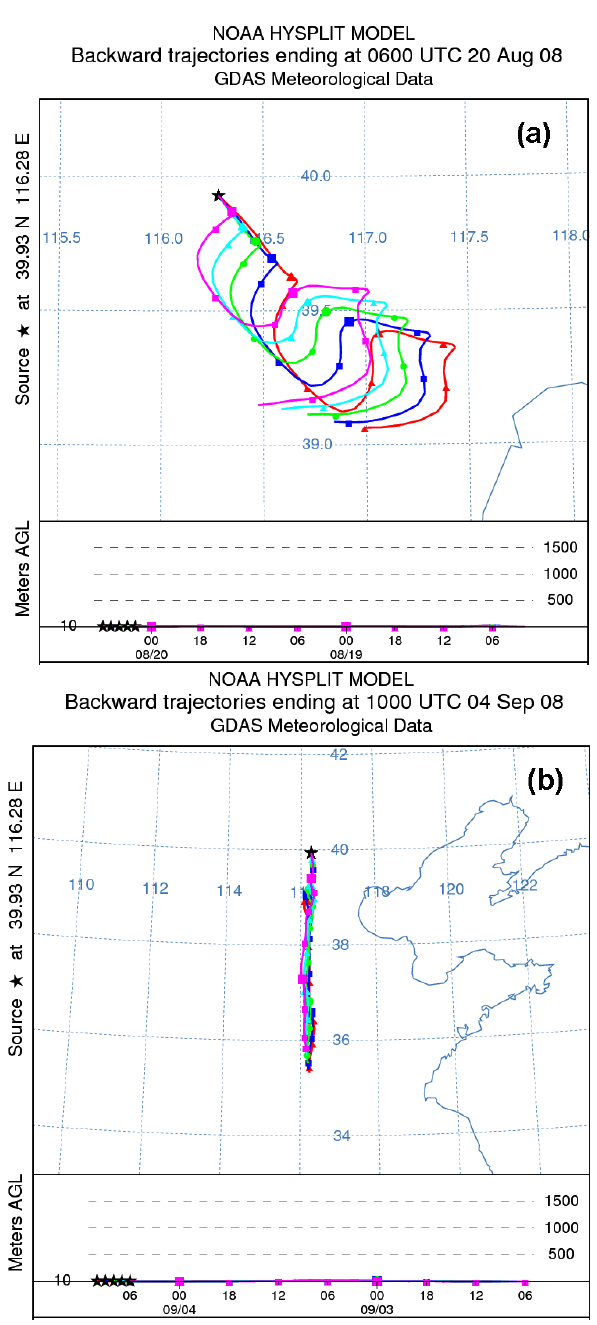
Fig. 9. 48h backward trajectories for Beijing on 20 August (a) and 4 September (b) , 2008 at a height of 10m. The multiple tracks (1 track per hour) in figures show the sources during the measurement